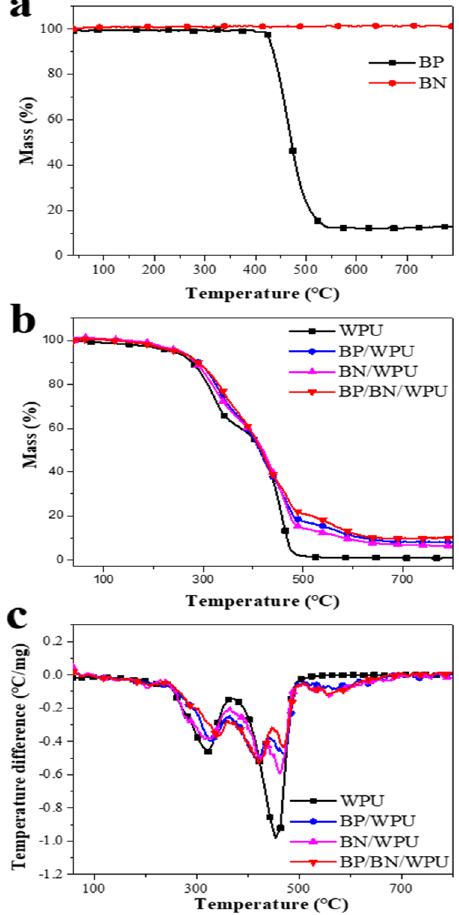
Figure 2. ( a ) the TGA curves of BP and BN; ( b ) the TGA curves of WPU, BP / WPU, BN / WPU and BP / BN / WPU; and ( c ) the resulted DTG curves of WPU, BP / WPU, BN / WPU and BP / BN / WPU.